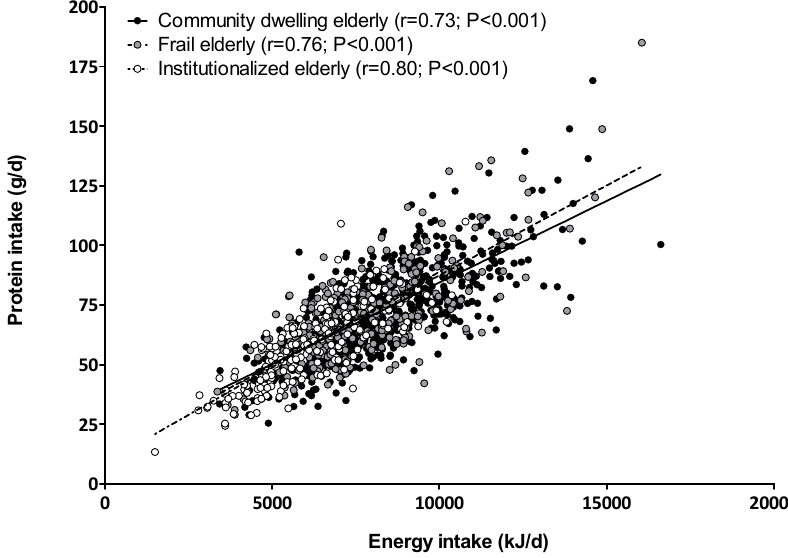
Figure 1. Scatterplot of dietary energy and protein intake in community ‐ dwelling, frail and institutionalized elderly people.